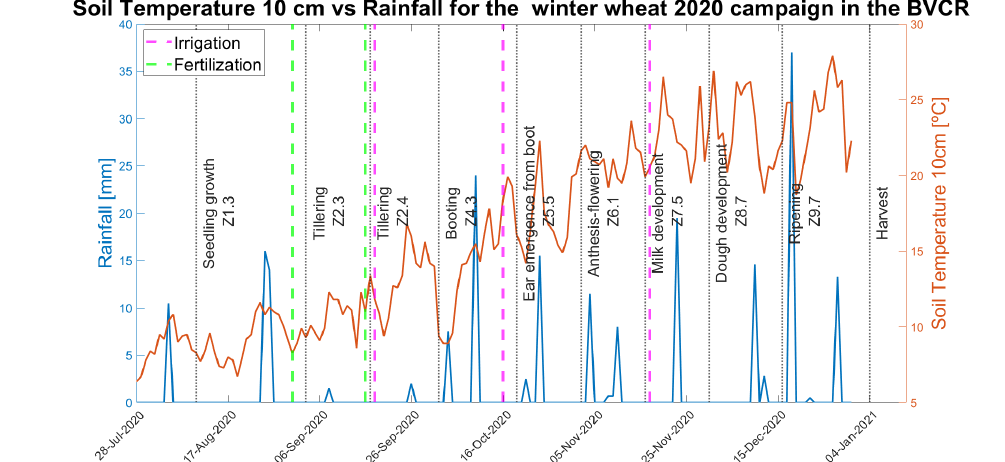
Figure 3. Meteorological data, soil temperature at 10 cm, and rainfall in the BVCR study site against winter wheat phenological